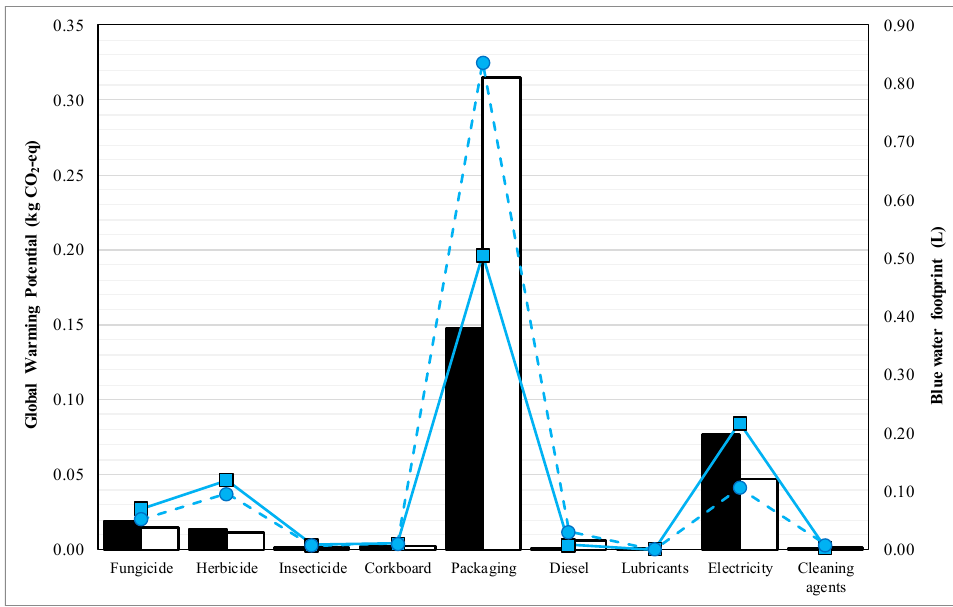
Figure 17. Global warming potential (bars) versus blue water footprint (lines) for wine production in case study I (closed bars and solid line) and case study II (open bars and dashed line).